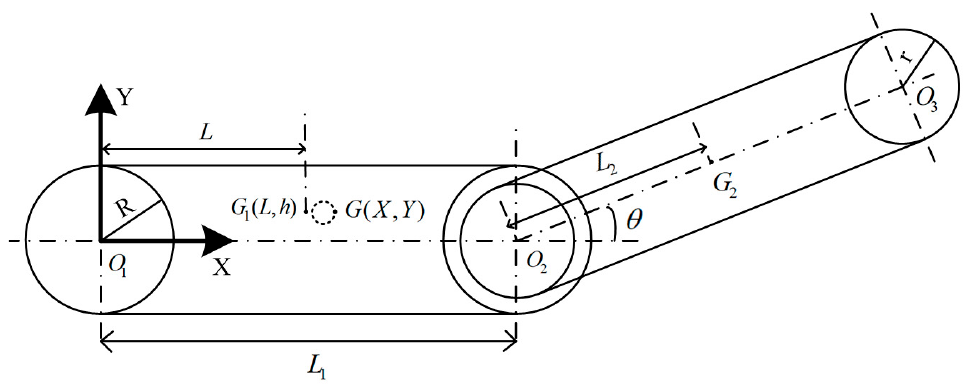
Figure 5. The trajectory of the robot’s center of mass. Therefore, the trajectory of the robot’s center of mass is a circle with